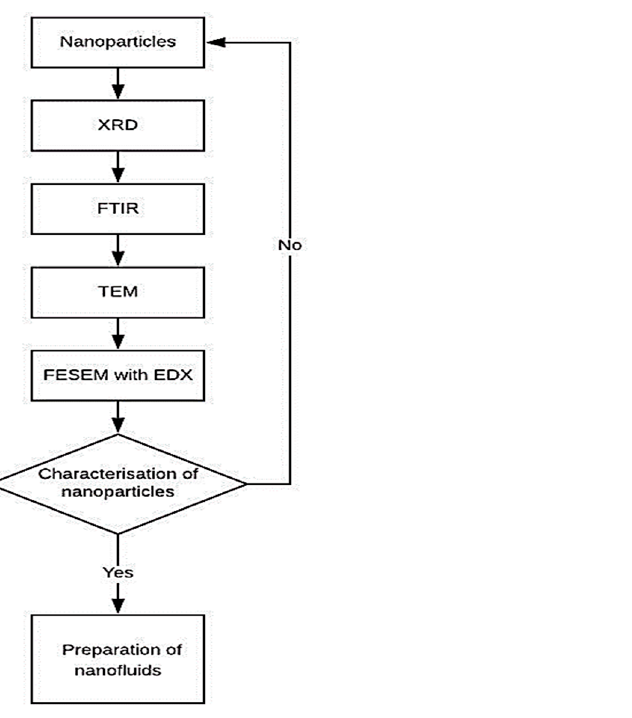
Figure 1. Flow chart of the material characterization, FTIR = Fourier Transform Infrared Spectroscopy; EDX=Energy ‐ dispersive X ‐ ray spectroscopy.